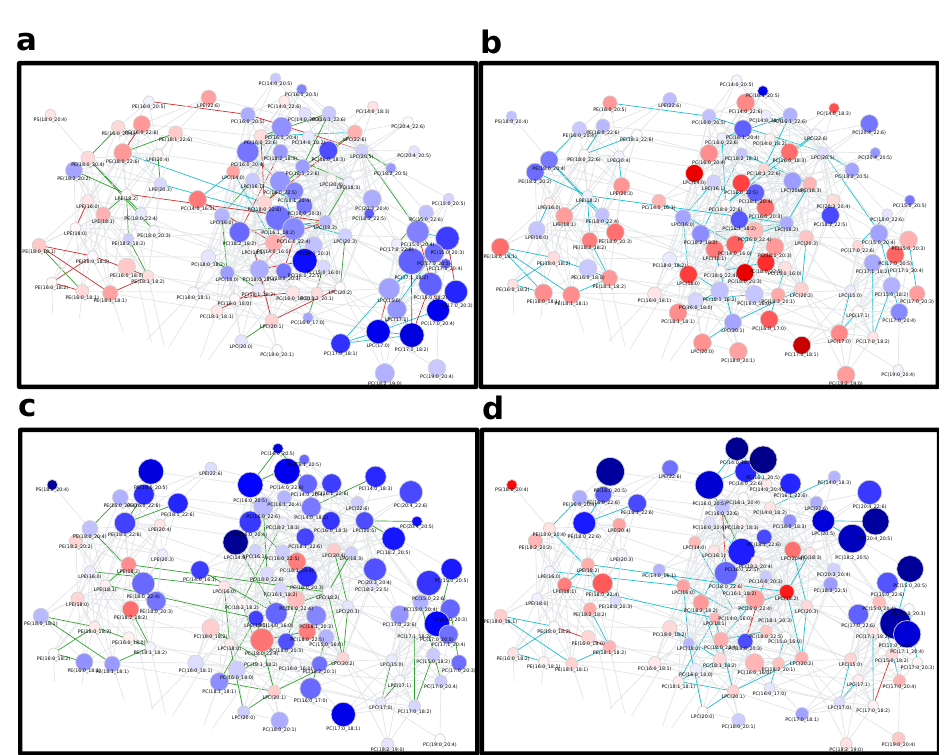
Figure A6. Detailed view on the PC/PE subnetwork from Kyle et al. [22] comparing ( a ) Tod- dler to Children, ( b ) Children to Teenager, ( c ) Teenager to Young Adults and ( d ) Young Adults to Older Adults.